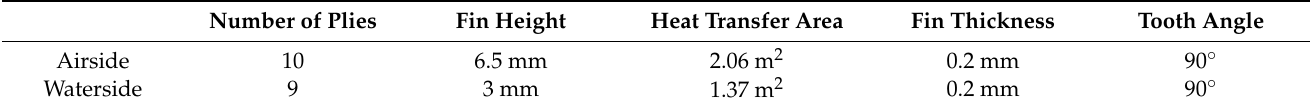
Table 1. Structural parameters of water-cooled charge air